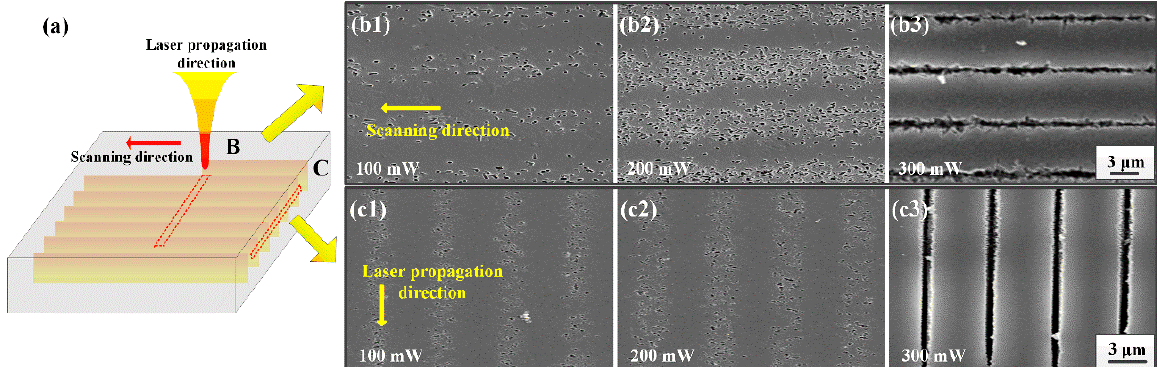
Figure 5. Schematic diagram of Bessel beam propagation inside PTR glass. ( a ) SEM images of nano-crystal formation along scanning direction ( b ) and along propagation direction ( c ) with different writing powers after HT time halved.